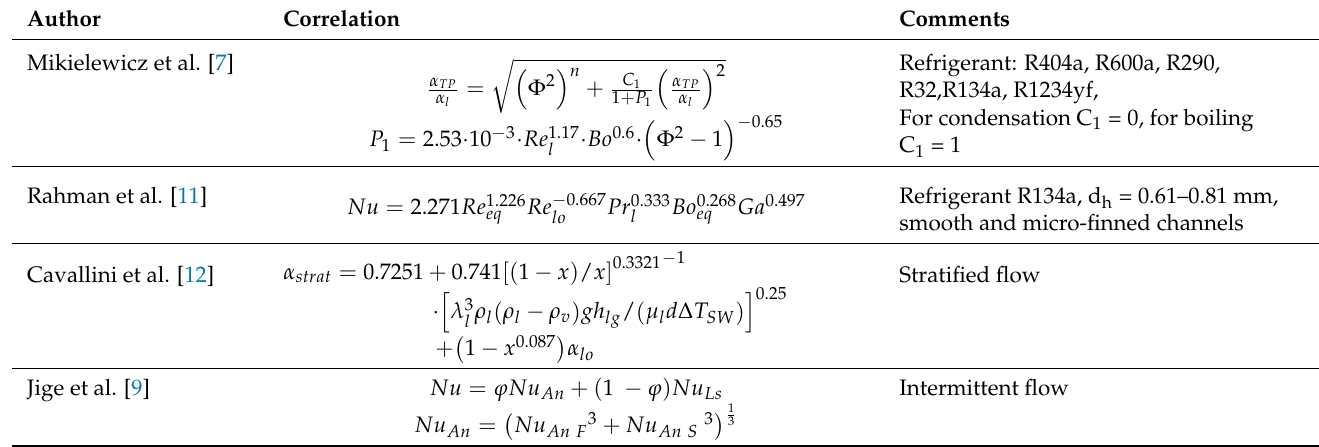
Table 2. Correlation described heat transfer during the condensation process of new refrigerants for different flow